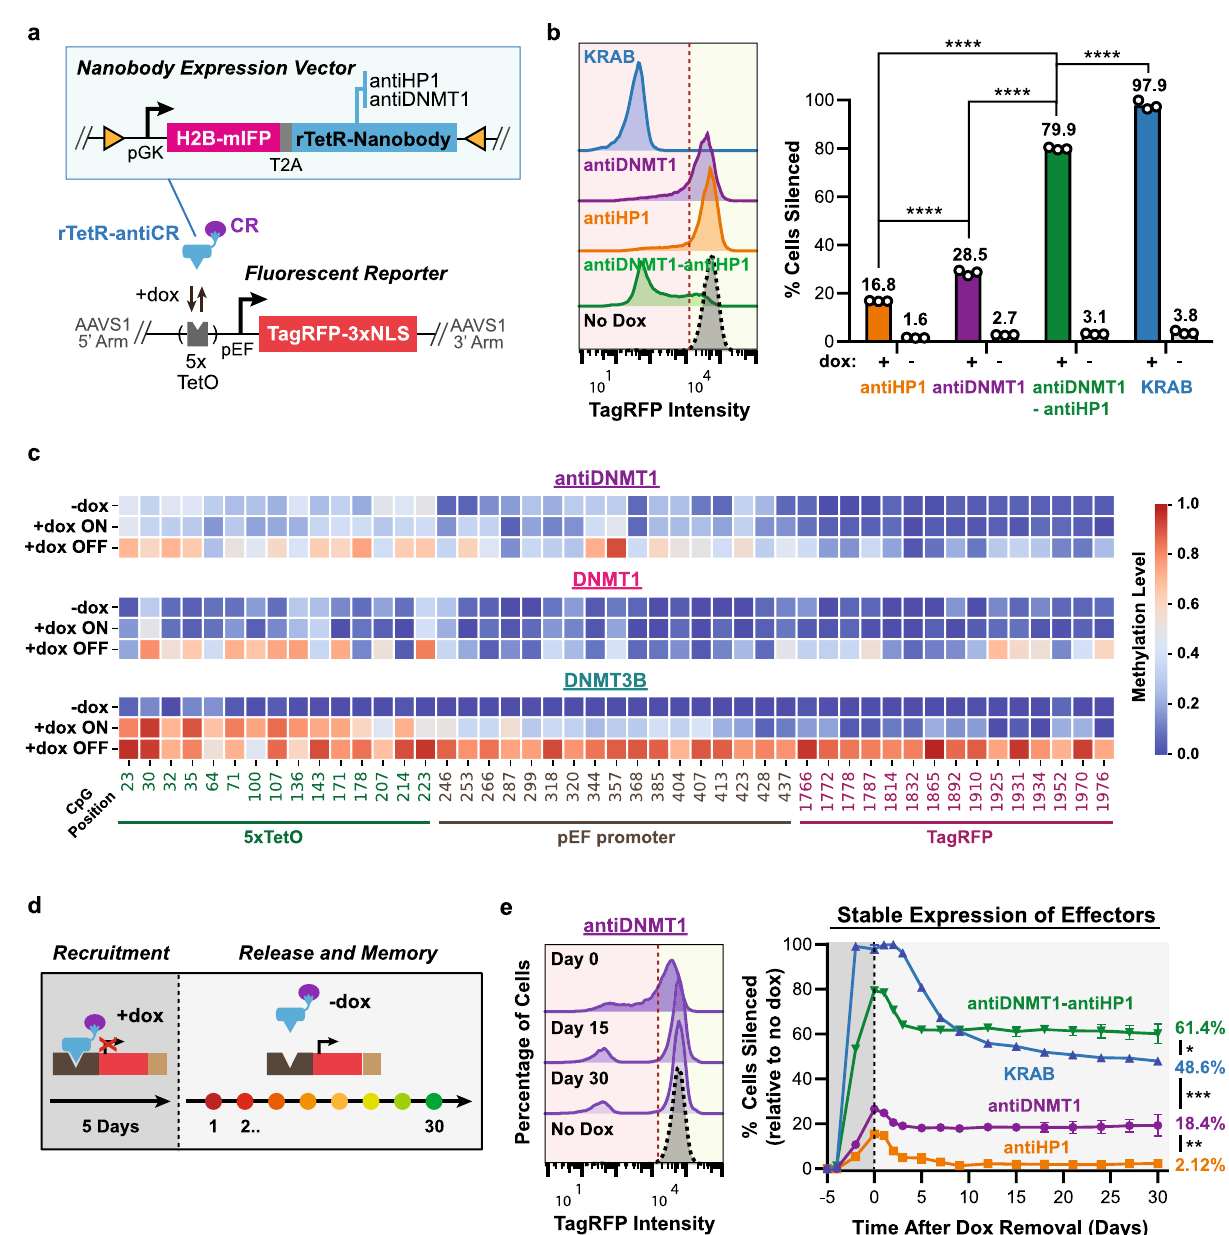
Fig. 2 Nanobody-mediated recruitment of endogenous chromatin regulators can silence gene expression and confer memory. a Construct for constitutive coexpression of H2B-mIFP and nanobody against CR (antiHP1 or antiDNMT1) fused with the rTetR DNA-binding protein (blue box, top) were expressed in HEK293T cells containing a TagRFP reporter (bottom). b Left: fl uorescence distributions of the TagRFP reporter after 5 days of recruitment (dox treatment) in cells stably expressing the nanobody constructs or rTetR-KRAB were analyzed by fl ow cytometry to determine the percentage of cells with the reporter silenced (left of the red dotted line). Right: means of percentages cells silent were calculated from 3 replicates. Statistical analysis by two- tailed Tukey ’ s test (antiHP1 vs. antiDNMT1: **** p = 5.6e − 6; antiHP1 vs. antiDNMT1-antiHP1: **** p = 2.5e − 13; antiDNMT1 vs. antiDNMT1-antiHP1: **** p = 1.8e − 11; antiDNMT1-antiHP1 vs. KRAB: **** p = 1.7e − 7). c Targeted bisul fi te sequencing of the reporter after 5 days of recruitment with antiDNMT1, DNMT1, and DNMT3B ( + dox), compared to untreated cells expressing the same effectors ( − dox). Dox-treated cells were sorted based on the silencing of the TagRFP reporter labeled as + dox ON and + dox OFF (see Supplementary Fig. 2a for representative gating). CpG positions are calculated relative to the start of the most upstream TetO site. Positive and negative controls for DNA methylation are shown in Supplementary Fig. 2b. d Experimental design for investigating epigenetic memory: rTetR-effectors were recruited to the reporter for 5 days ( + dox) and then released ( − dox). Memory was monitored after dox removal via fl ow cytometry throughout 30 days. e Silencing and memory dynamics data (right) for the experiment described in d with representative fl ow cytometry histogram for antiDNMT1 at day 0, 15, 30 after dox removal (left). The percentage of cells silenced was normalized to the no dox control to adjust for any background silencing ( “ Methods ” ). Means are from three replicates. SDs are plotted but are too small to show for most data points. Statistical analysis by two-tailed Tukey ’ s test at day 30 after dox removal (antiHP1 vs. antiDNMT1: ** p = 0.0076; antiDNMT1 vs. KRAB: *** p = 0.00026; KRAB vs. antiDNMT1-antiHP1: * p = 0.043). Source data are available in the Source Data fi